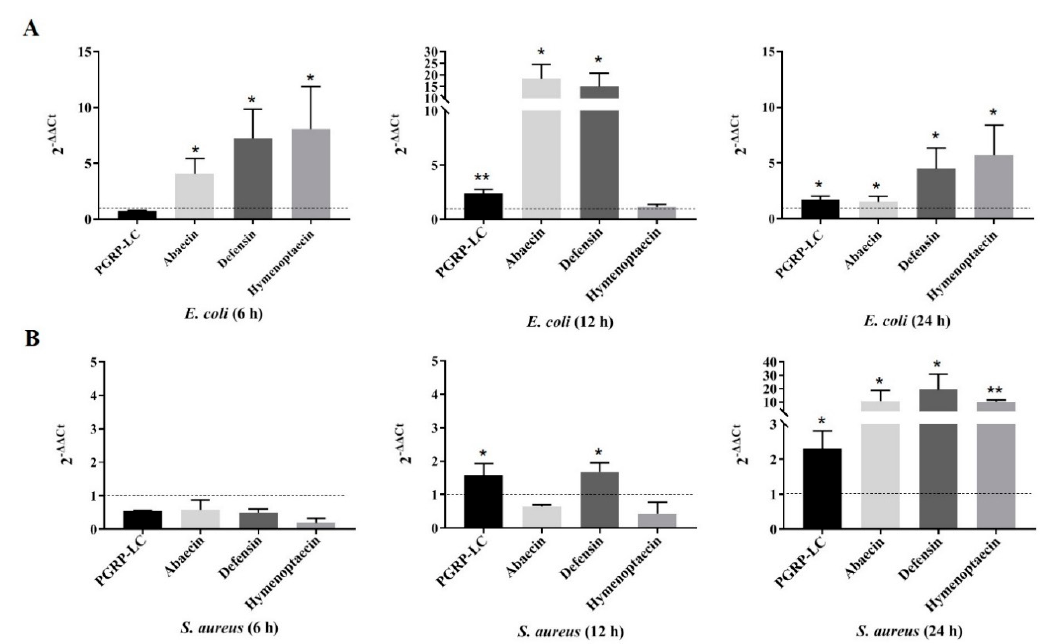
Figure 1. Changes in the expression levels of the PGRP-LC , abaecin , defensin and hymenoptaecin genes in the bumblebee Bombus lantschouensis after challenge with the Gram-negative bacterium E. coli and the Gram-positive bacterium S. aureus . ( A ) Changes in the expression levels of the PGRP-LC , abaecin , defensin and hymenoptaecin genes induced by the infection with E. coli at 6 h, 12 h and 24 h in B. lantschouensis workers. ( B ) Changes in the expression levels of the PGRP-LC , abaecin , defensin and hymenoptaecin genes in B. lantschouensis workers triggered by the S. aureus infection at 6 h, 12 h and 24 h. The X-axis indicates the gene names, and the Y-axis indicates the 2 − △△ Ct value. ** indicates p -value < 0.01, and * indicates p -value between 0.01 and 0.05. The dashed line indicates the differential expression level of the four genes in the control group (a 2 −ΔΔ Ct value of 1).